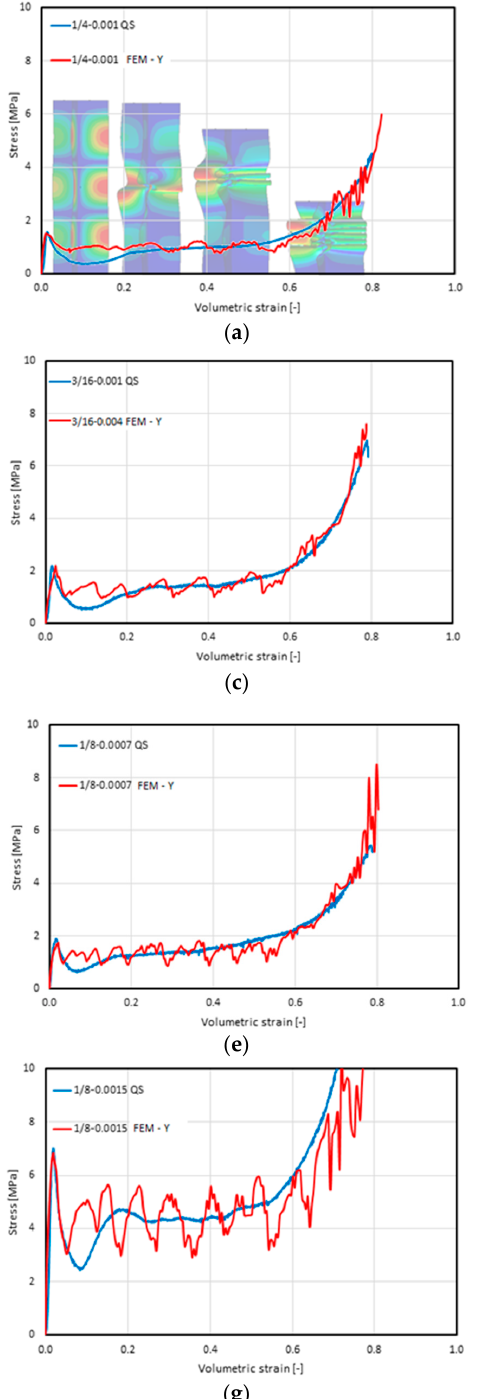
Figure 15. Summary of the stress–volumetric strain characteristics obtained using the FEM–Y model (FEM–Y) and experimentally in the quasi-static compression (QS) test [21] of the following material types: ( a ) 1/4-5052-0.001; ( b ) 16-5052-0.0007; ( c ) 3/16-5052-0.001; ( d ) 3/16-5052-0.0015; ( e ) 1/8-5052-0.0007; ( f ) 1/8-5052-0.001; and ( g ) 1/8-5052-0.0015.